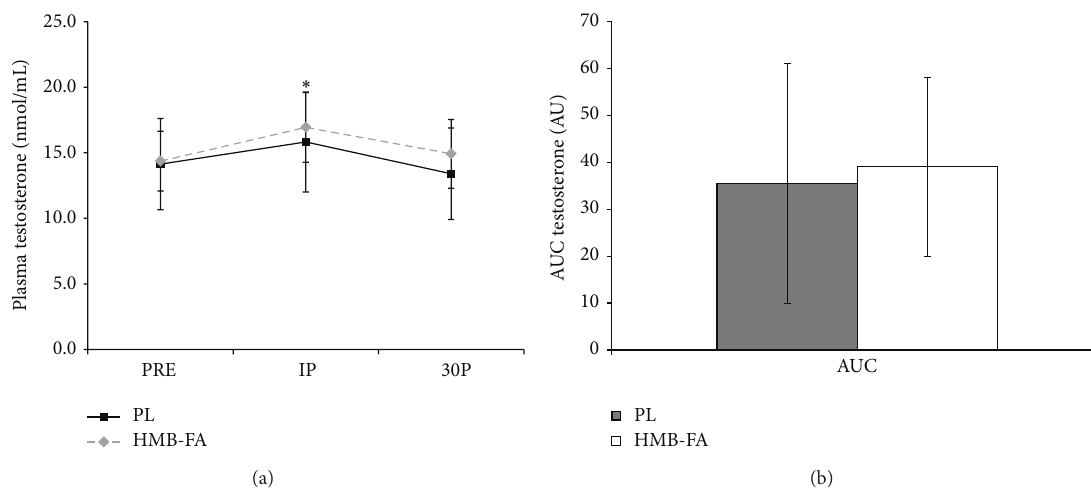
Figure 2: (a) Plasma testosterone concentration values for placebo (PL) and 𝛽 -hydroxy- 𝛽 -methylbutyrate free acid (HMB-FA) groups before exercise (PRE), immediately after exercise (IP), and 30 minutes after exercise (30P). ∗ Both groups significantly elevated from PRE ( 𝑃 ≤ 0.01 ). (b) Area under the curve (AUC) analysis for plasma testosterone levels for PL and HMB-FA groups. Data were reported as mean ± SD.